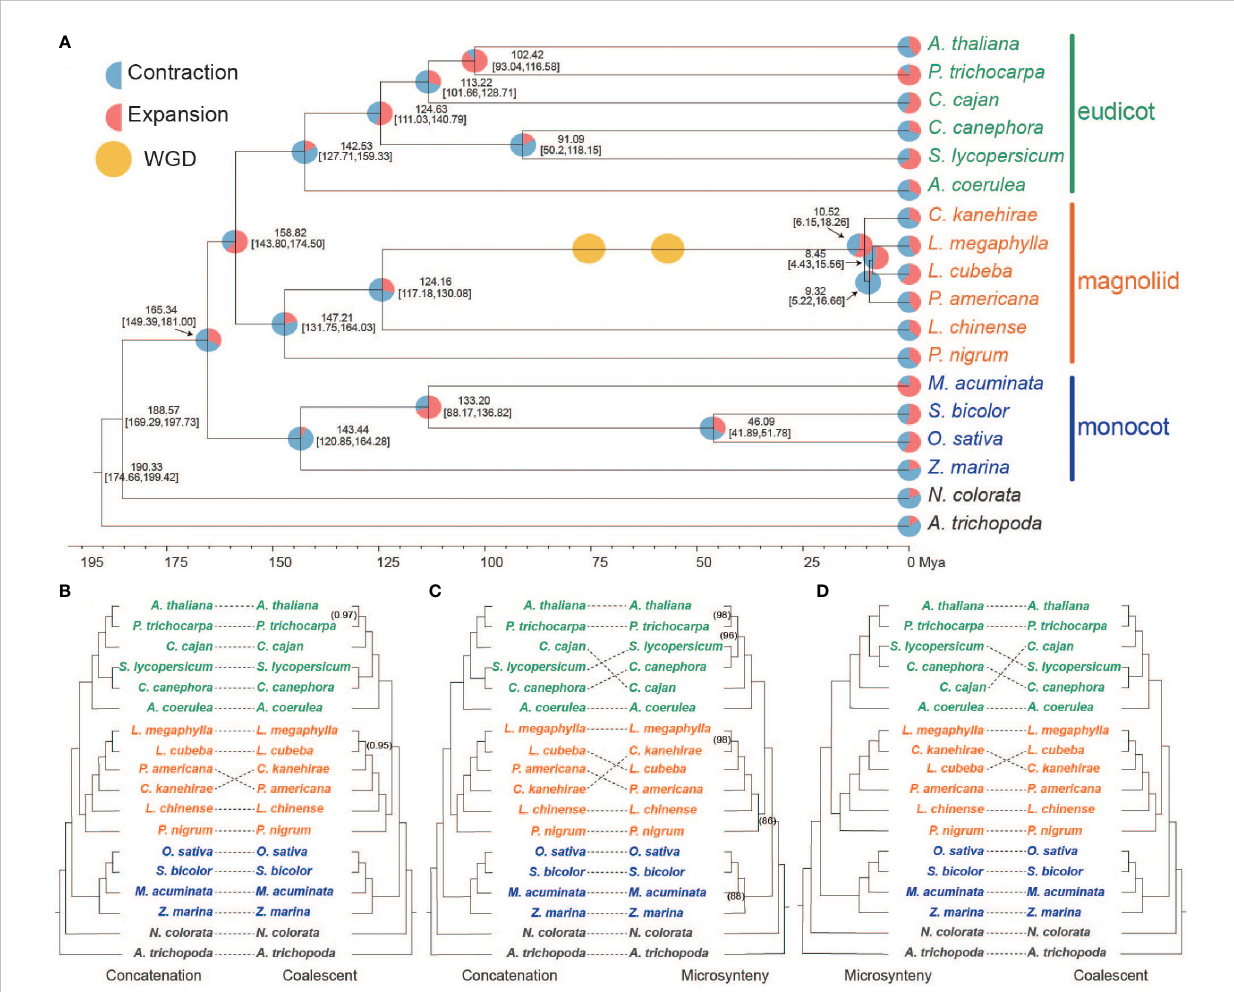
FIGURE 1 Phylogenomic analysis of three major angiosperm groups. (A) Phylogenetic tree of 18 plant species generated by the concatenation-based method. Pie charts indicate the predicted expansion (red) and contraction (blue) of the gene family. The numbers represent divergence time of each node (Mya, million years ago), and values in brackets are 95% con fi dence intervals for the time of divergence. The yellow circle shows the WGD events identi fi ed in Lauraceae species. (B) Comparison of phylogenetic trees produced by the concatenation- and multi-species coalescent (MSC)-based methods. (C) Comparison of phylogenetic trees generated using concatenation- and microsynteny-based methods. (D) Comparison of phylogenetic trees produced using the microsynteny- and MSC-based